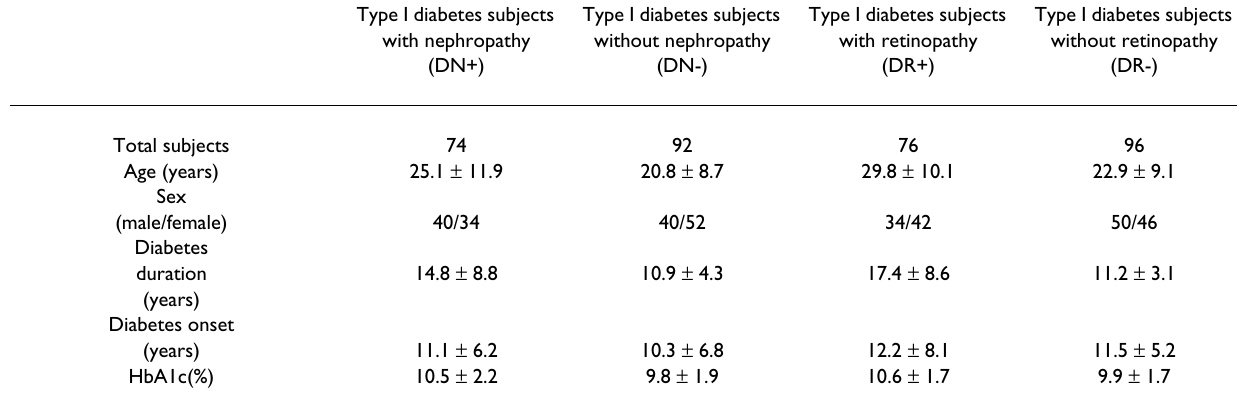
Table 1: Clinical characteristics by study